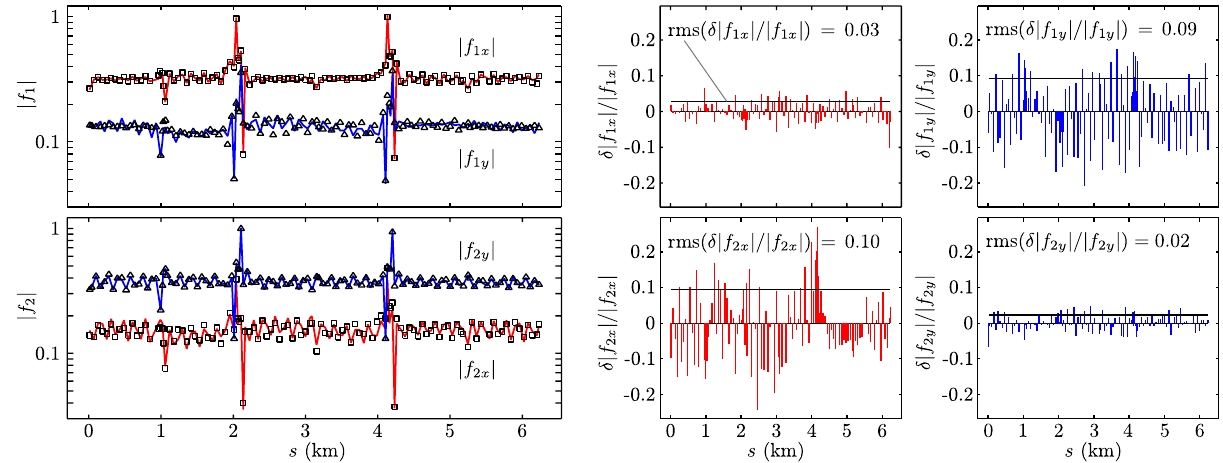
FIG. 7. Coupled betatron amplitude functions at BPMs (dots) obtained from the columns of matrix V f and compared to the model values (solid lines). The relative difference between the model values of optical functions and their measured values ( (cid:2) j f j (cid:1) j f j j f ) is shown on the right. The same measured turn-by-turn data was used as in Fig. 2. The model was calibrated 1 x measured 1 x model with the orbit response matrix technique [10,11]. However, since we do not know the real optics it is not clear which method (orbit response or MIA) provides the best accuracy.